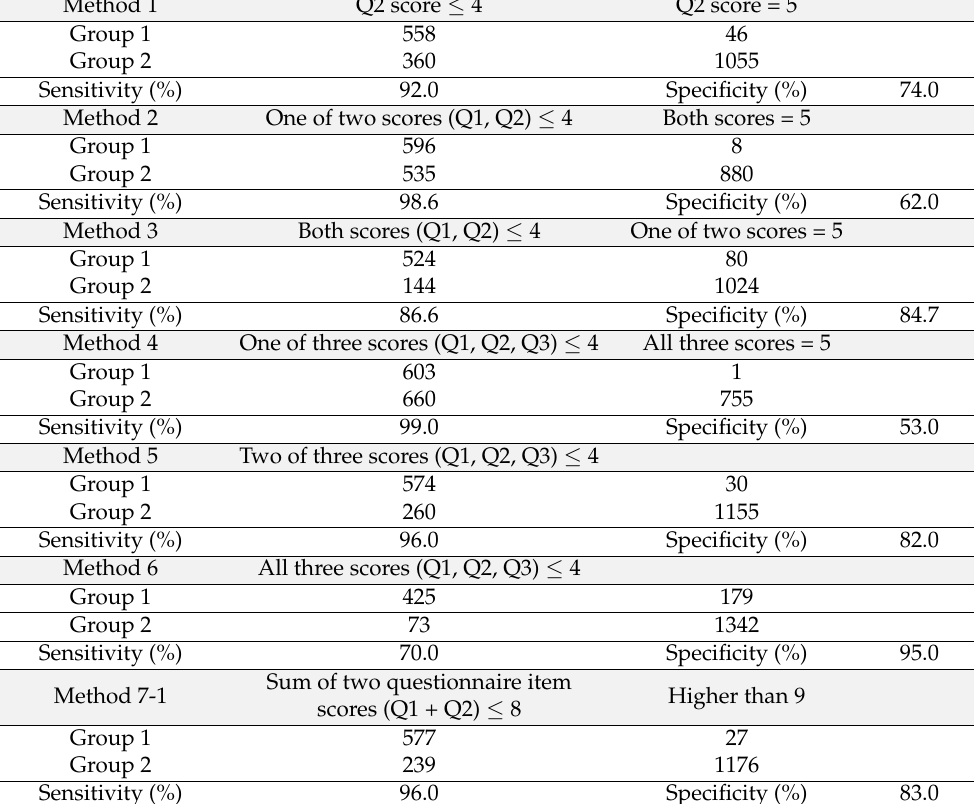
Table 5. Sensitivity and specificity according to the survey order methods of selected representative questionnaire items for diagnosing Group